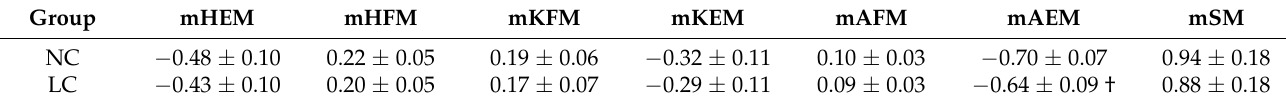
Table 6. Mean joint moments in the NC and the LC.